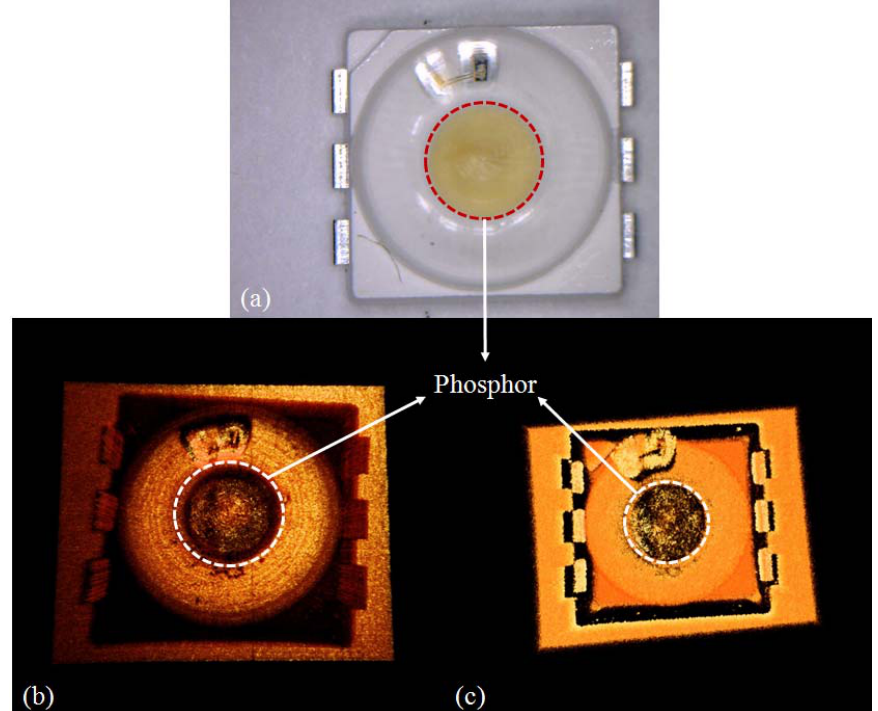
Figure 6. Circle chip LED. ( a ) Microscope top view image; ( b ) 850 nm SD-OCT top view 3D image; ( c ) 1,310 nm SS-OCT top view 3D